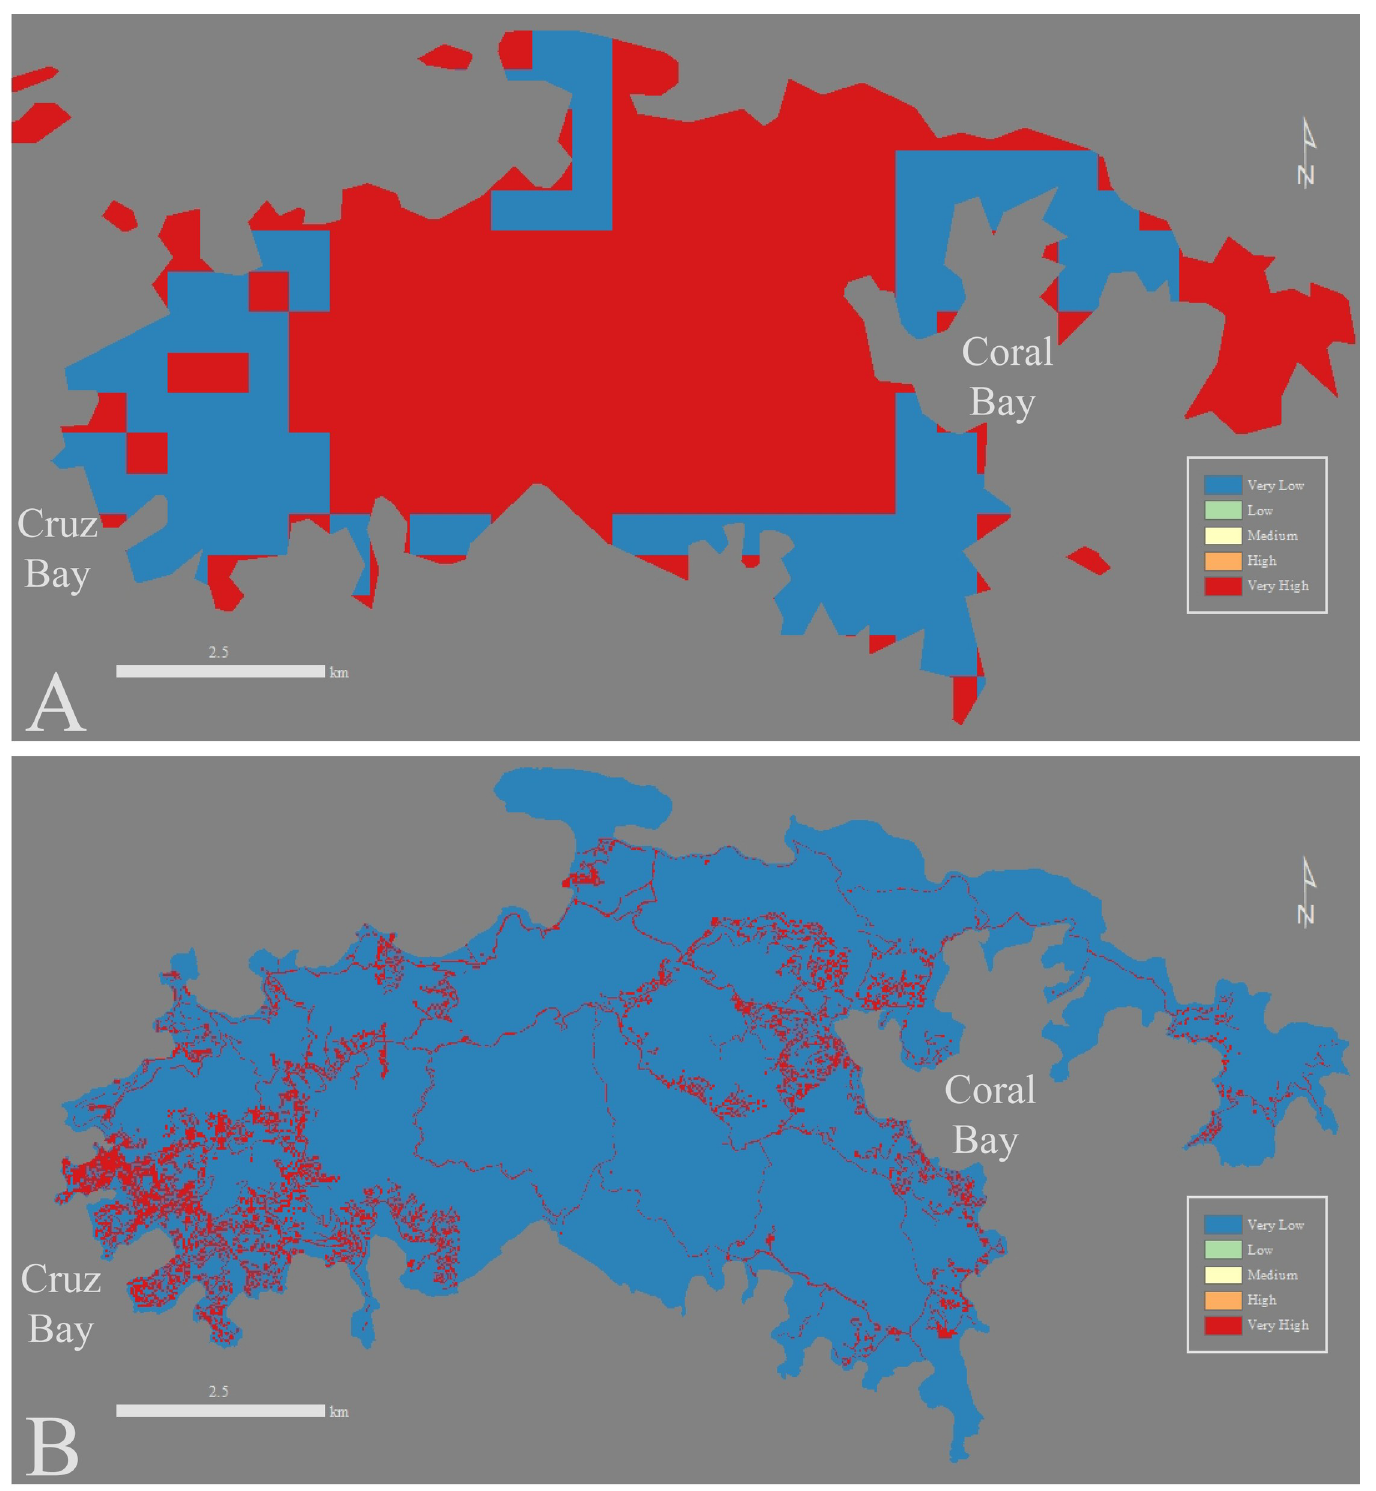
Fig 4. Agriculture, Grazing, Mining, and Development (AGMD) comparison between the global EVI (A) and EVI-STJ (B). The resolution differs drastically, when using higher resolution data the overall Risk Factors decrease and invert the pattern shown in Browning and Sawyer [47] EVI.